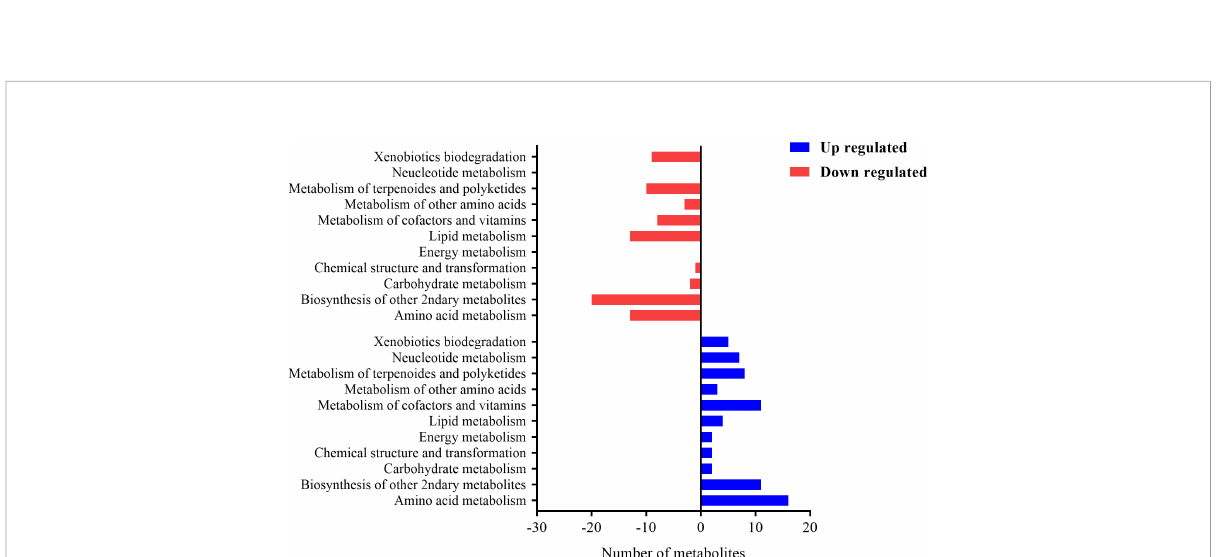
FIGURE 11 The histogram plot of KEEG pathway analysis of differential metabolites in EP+YG vs control group chickens. The number of metabolites involved in each pathway at the second level of the KEGG